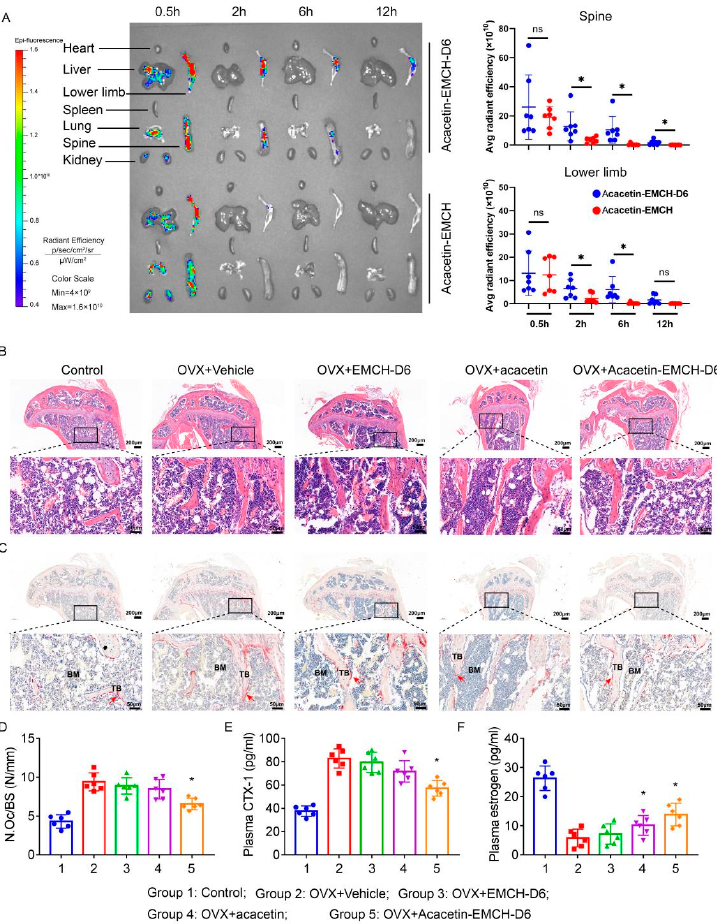
Figure 3. In vivo distribution of Acacetin-EMCH-D6 ( A ). Fluorescence of organs from mice sacrificed 30 min, 2 h, 6 h, and 12 h after intraperitoneal injection of FITC-labeled Acacetin-EMCH and Acacetin- EMCH-D6 (17.5 µ mol/kg). One week after surgery of ovariectomy (OVX), mice were treated with Acacetin-EMCH-D6 or acacetin (i.p., 17.5 μ mol/kg/3 days) for 5 weeks. H&E ( B ) and TRAP ( C ) staining were conducted on sections of proximal tibia. Representative microscopic images were shown and TRAP-positive osteoclast numbers ( D ) were calculated in each group. Graphs showed the levels of CTX-1 ( E ) and estrogen ( F ) in plasma. Sham-operated mice were used as control. * p < 0.05 versus the control group, n = 6. As shown in H&E staining results (Figure 3B), the OVX group exhibited considerable bone trabecular loss in the proximal tibia. Treatment with Acacetin-EMCH-D6 raised the trabecular density and thickness. TRAP staining results revealed that the number of TRAP-positive cells increased dramatically in the OVX group (Figure 3C,D), which was significantly reversed by treatment with Acacetin-EMCH-D6. Treatment with Acacetin or EMCH-D6 alone did not affect the histological changes in the proximal tibia after ovari- ectomy. 3E) and reduced estrogen levels (Figure 3F) in plasma. Treatment with Acacetin-EMCH-